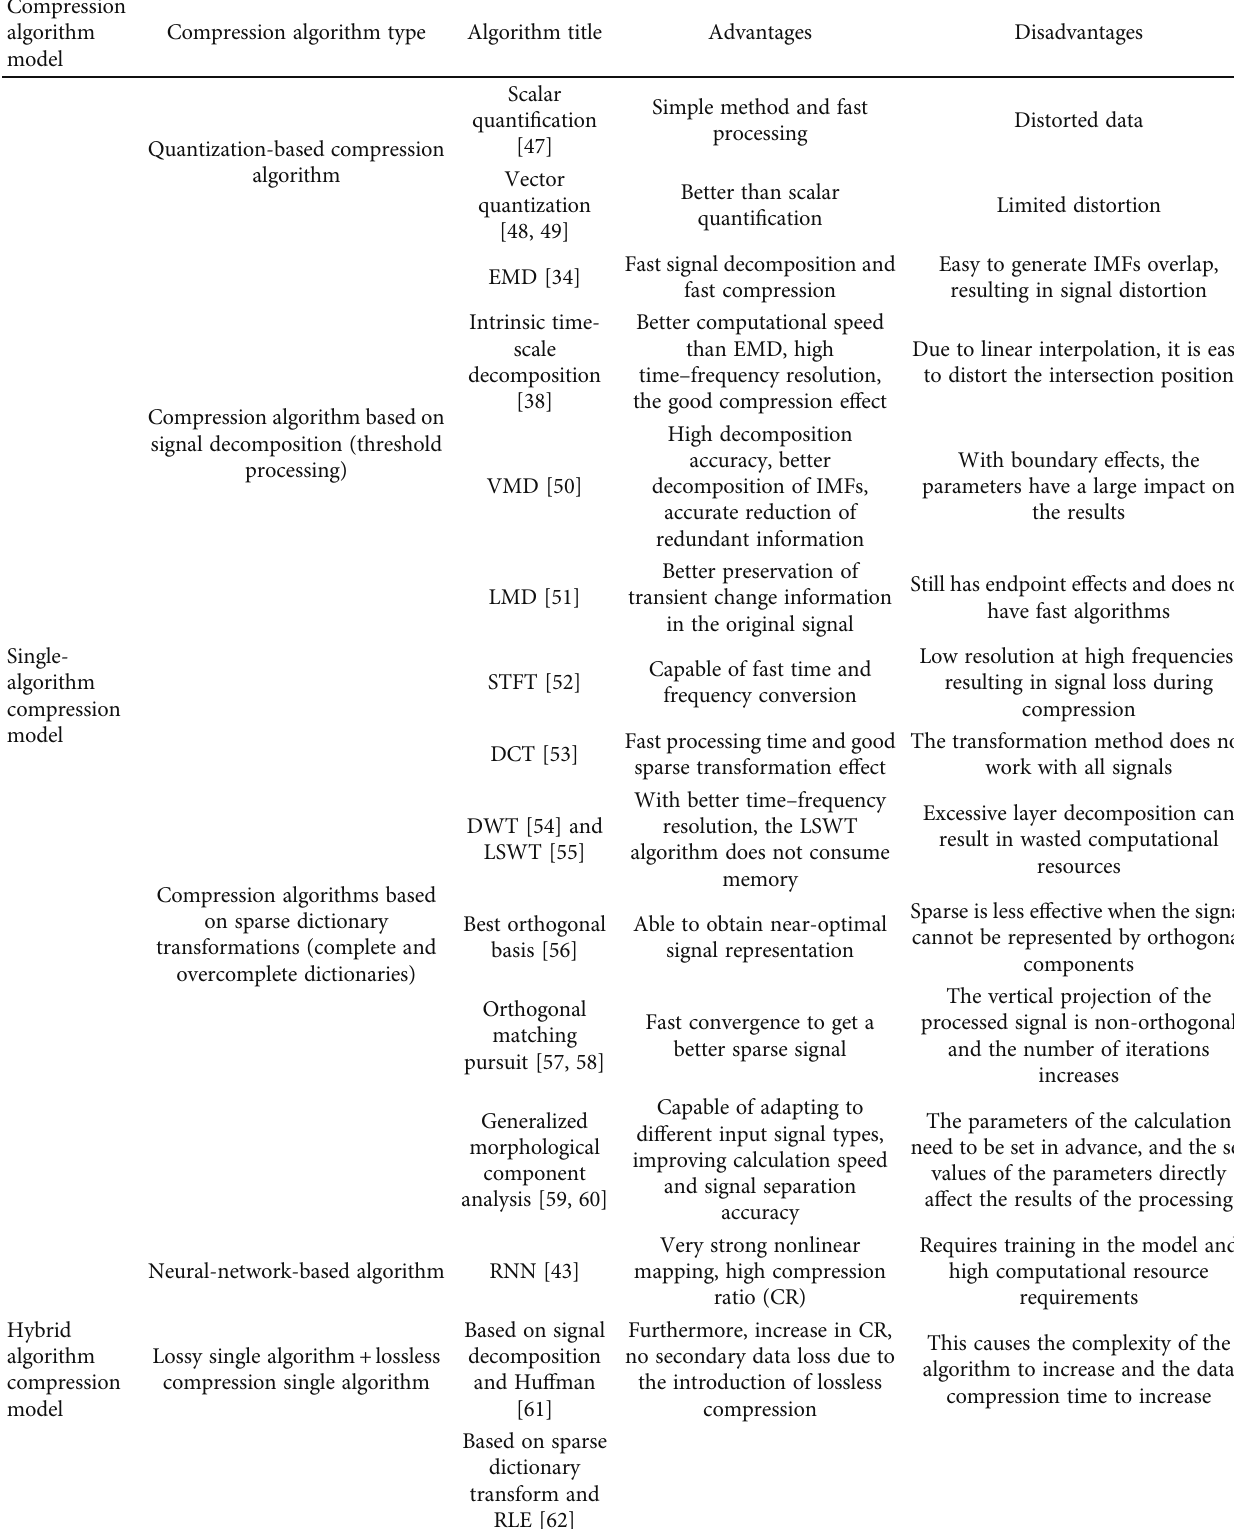
Table 2: Lossy compression